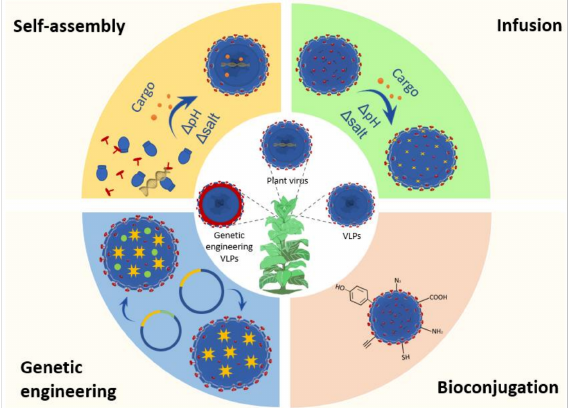
Figure 3. Strategies for functionalization of